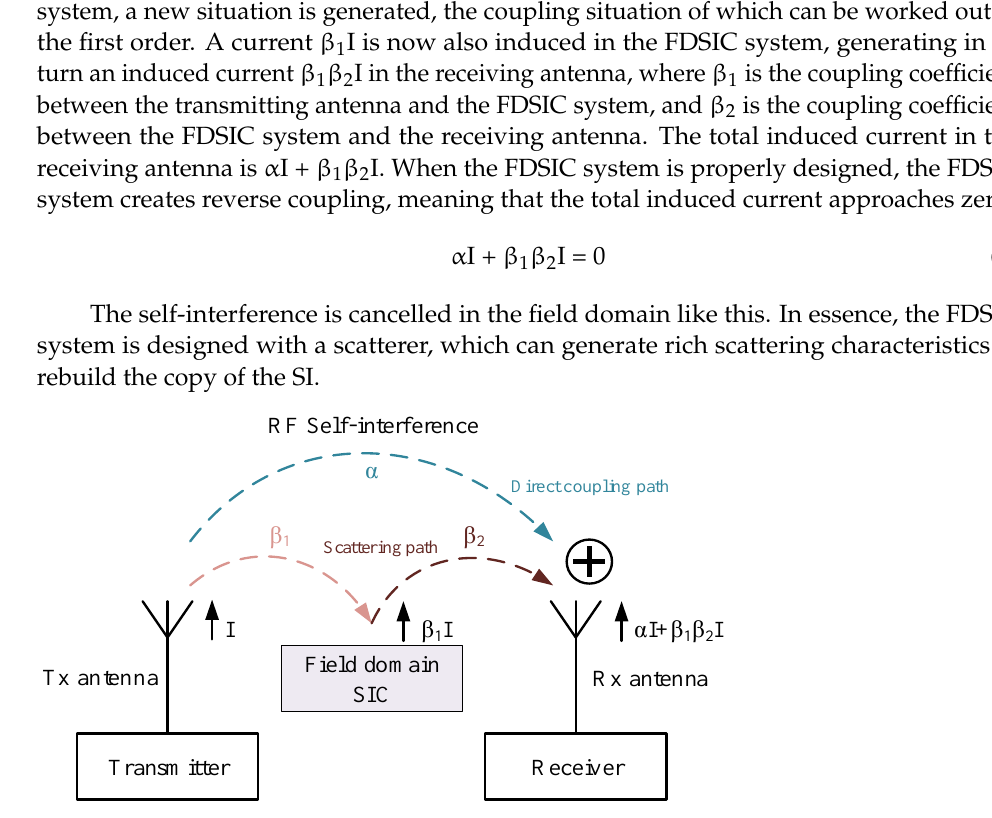
Figure 9. Operation mechanism of the